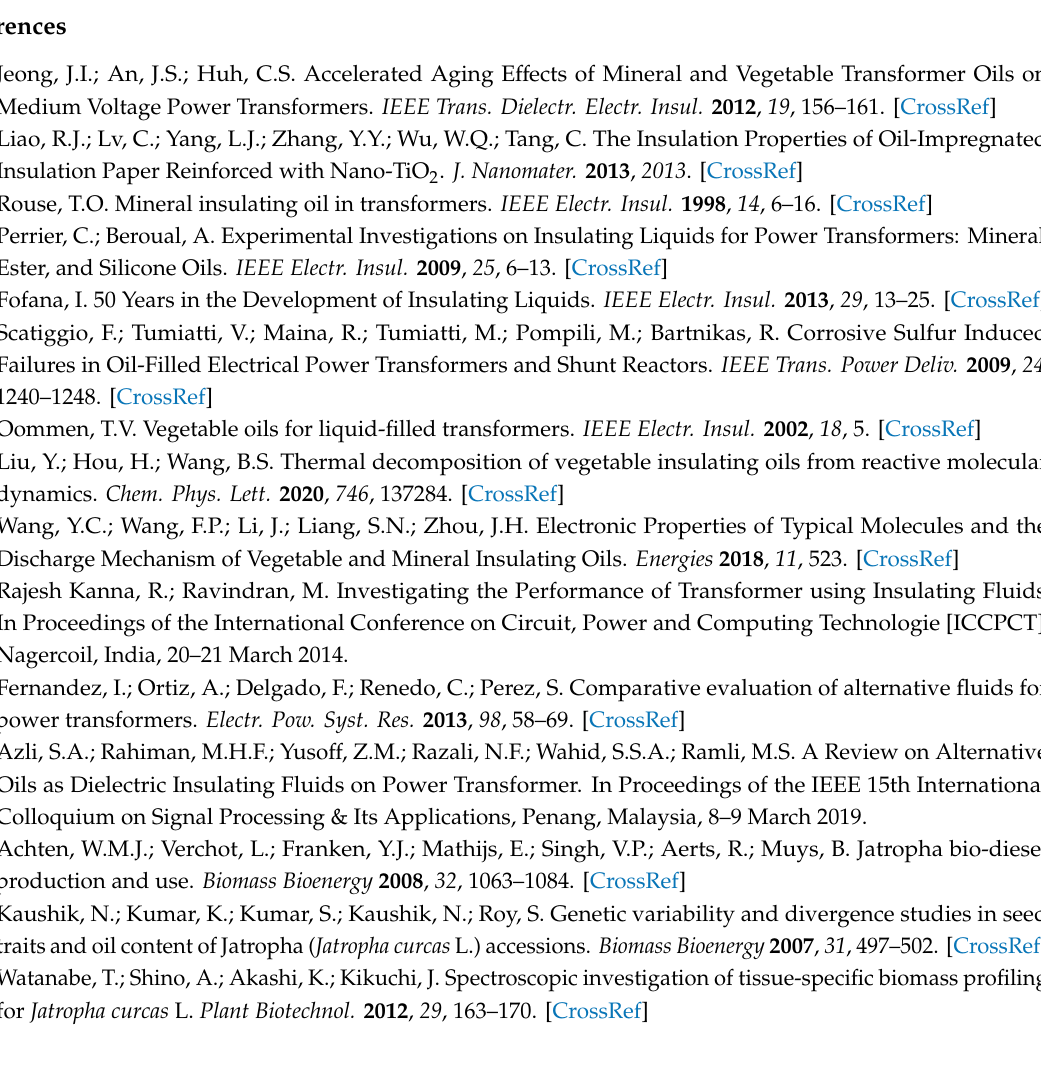
Figure S1: The Jatropha curcas seed oil treated at 4 ◦ C for 48 h, Figure S2: Mass spectrum of fatty acid analysis in CJCO and JNIO, Table S1: Detection processes of fatty acids in CJCO and JNIO, Table S2: Descriptive Statistics of CJCO and JNIO properties, Table S3: ANOVA of di ff erences in physical and chemical properties between CJCO and